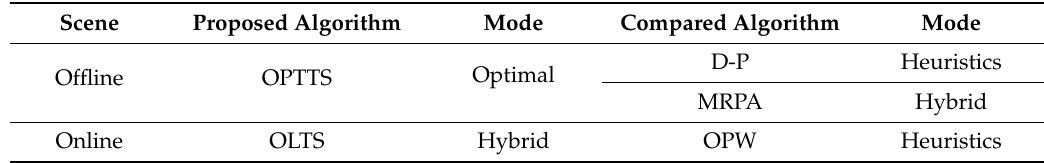
Table 3. Characteristics of compared algorithms.